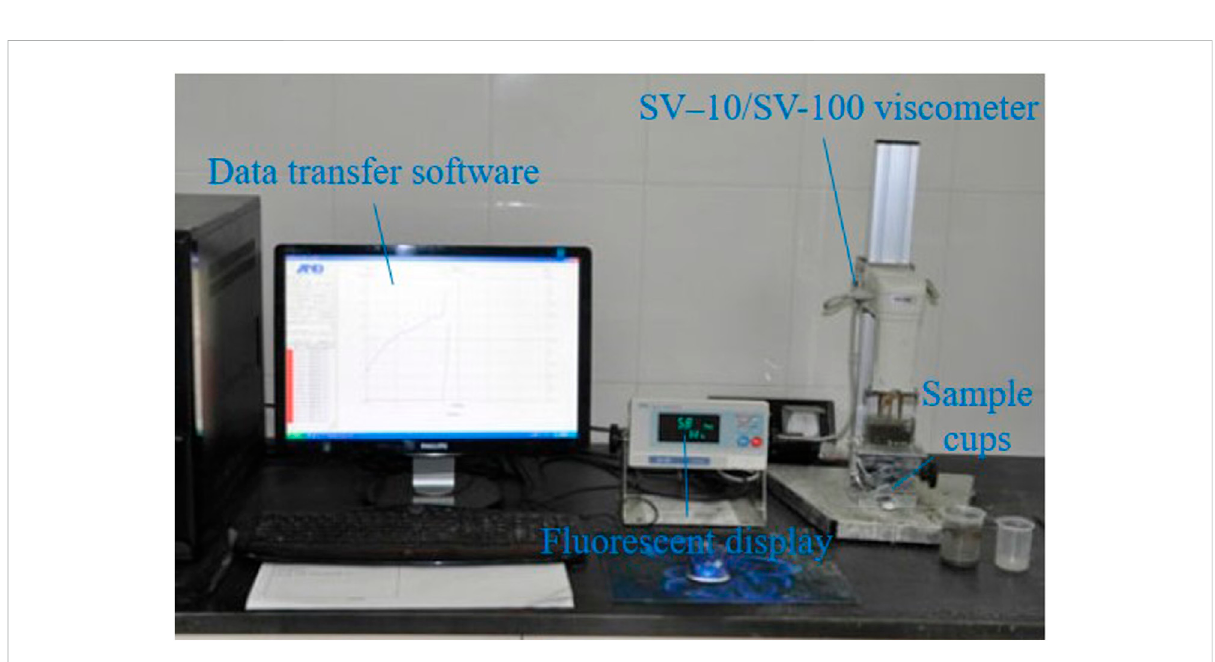
FIGURE 3 SV-10/SV-100 sine wave vibrating